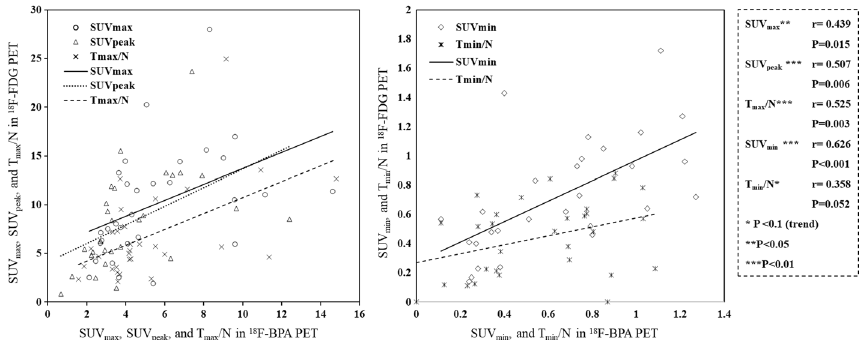
Fig. 5 The correlation of non-spatial point parameters, including SUV max , SUV peak , SUV min , T max / N , and T min / N between 18 F-FDG and 18 F-BPA PET for all patients. T max / N ; maximum tumor-to-normal tissue count ratio, T min / N minimum tumor-to-normal tissue count